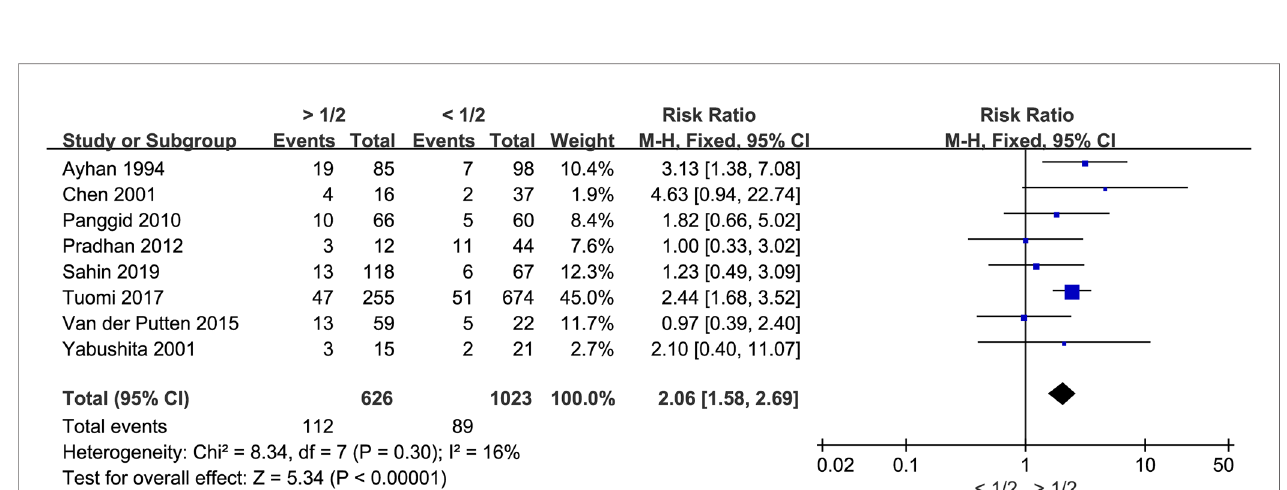
Frontiers in Oncology |